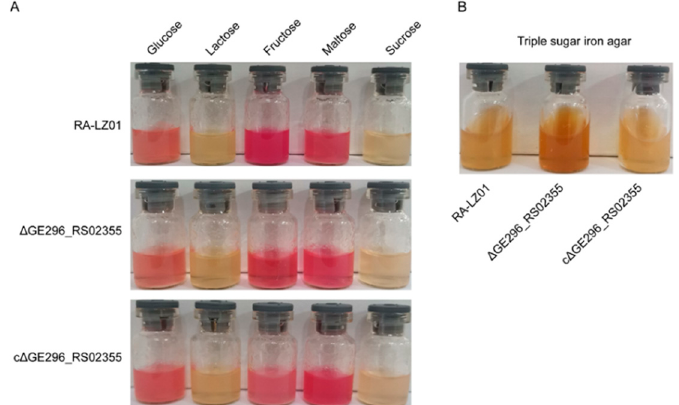
Figure 7. Biochemical experiments of parental strain RA-LZ01, deletion strain RA-LZ01 Δ RanQ , and supplement strain RA-LZ01c Δ RanQ . ( A ) Glycometabolism. ( B ) Triple Sugar Iron assay.